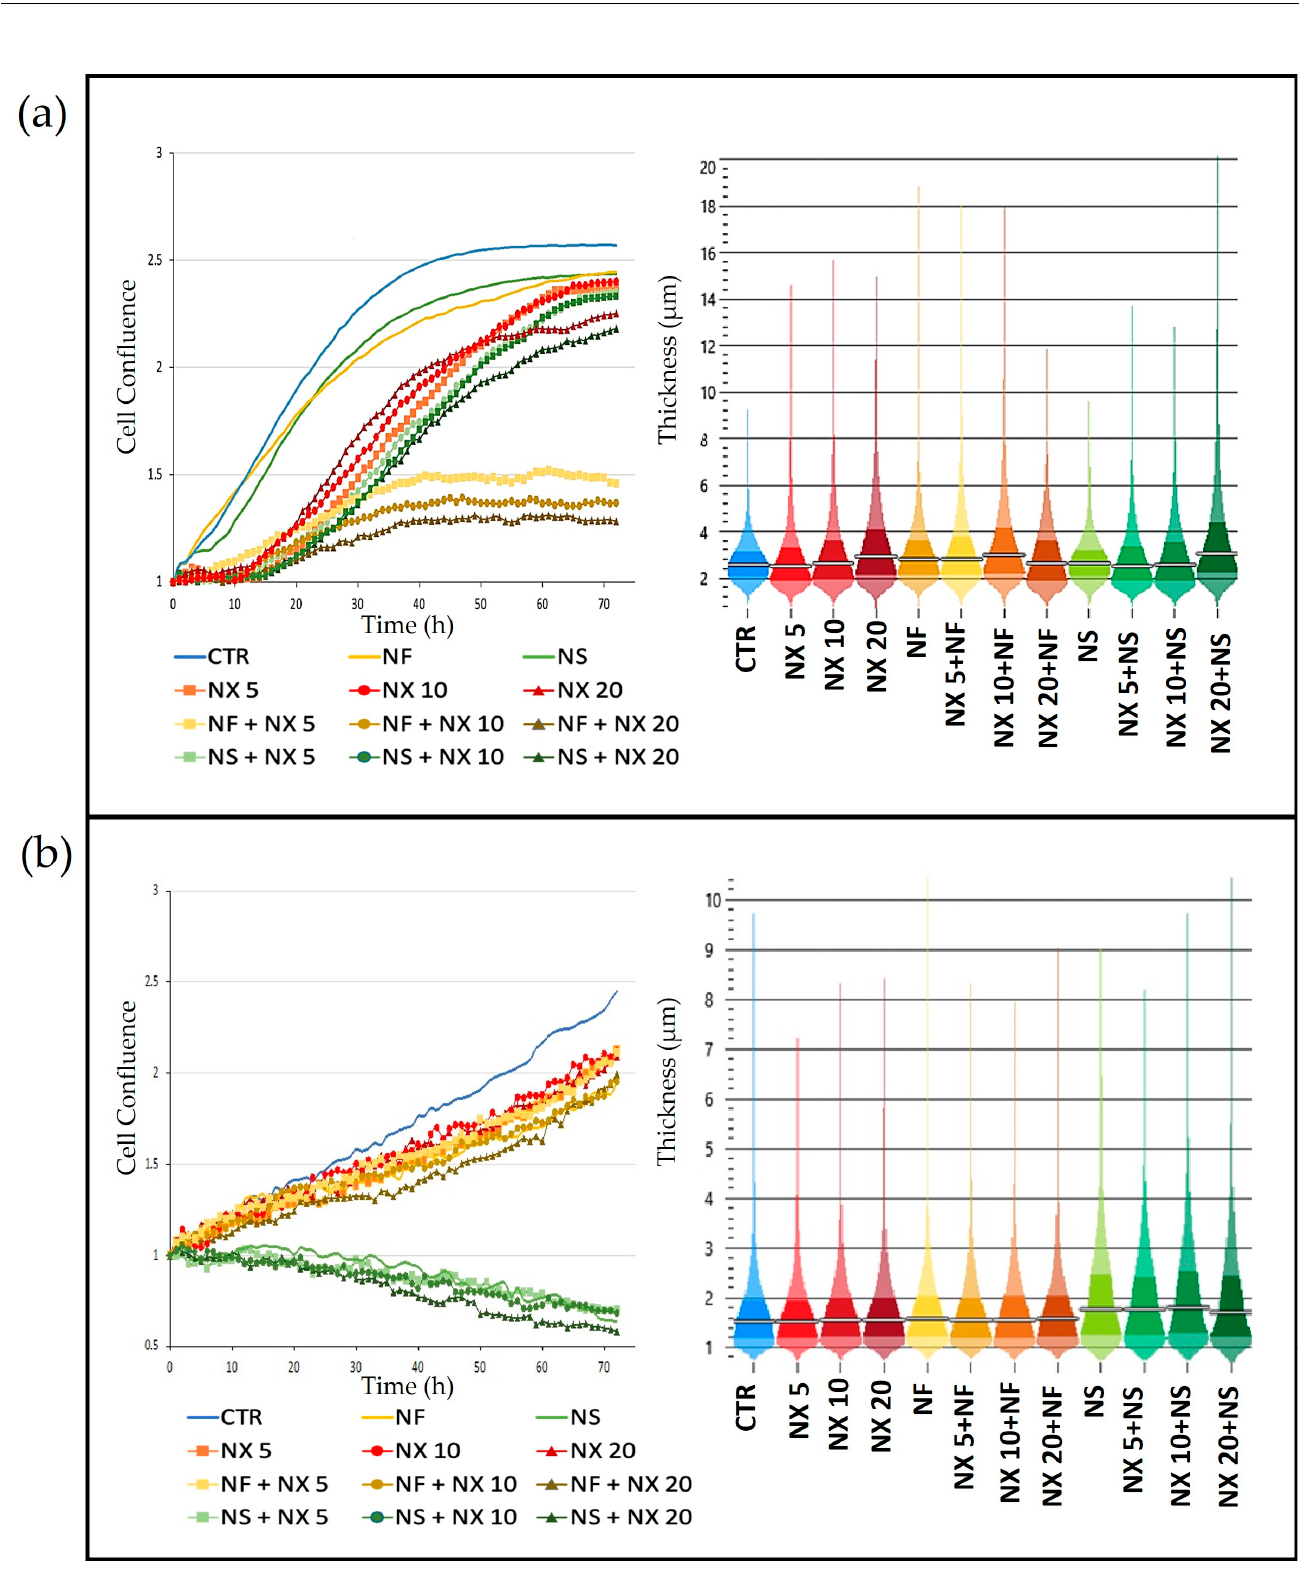
Figure 7. Cell confluence and thickness of ( a ) CHP-134 cells and ( b ) SH-SY5Y cells treated with NX at 5, 10, and 20 µg/mL, or NF, NS (0.05 mg/mL), NX in combination with NF, and NX in combination 5, 10, and 20 µ g/mL, or NF, NS (0.05 mg/mL), NX in combination with NF, and NX in combination with NS. with